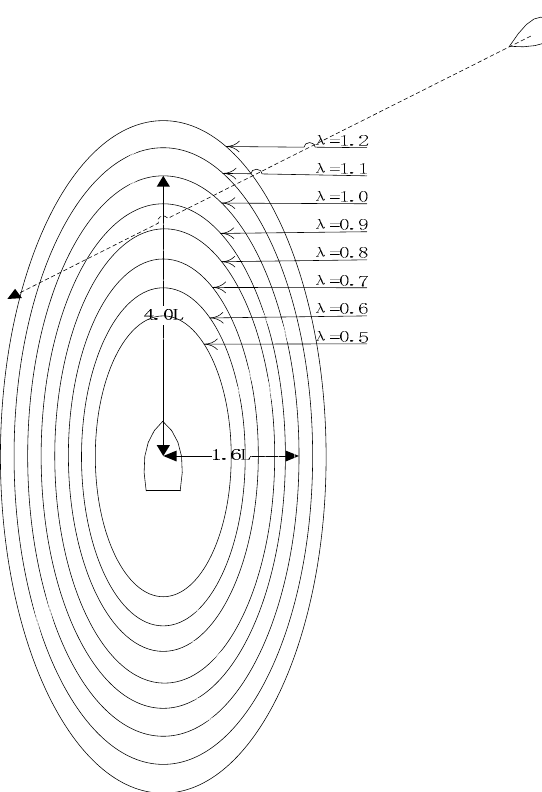
Figure 8. Extent of the proposed approach based on the ship domain.